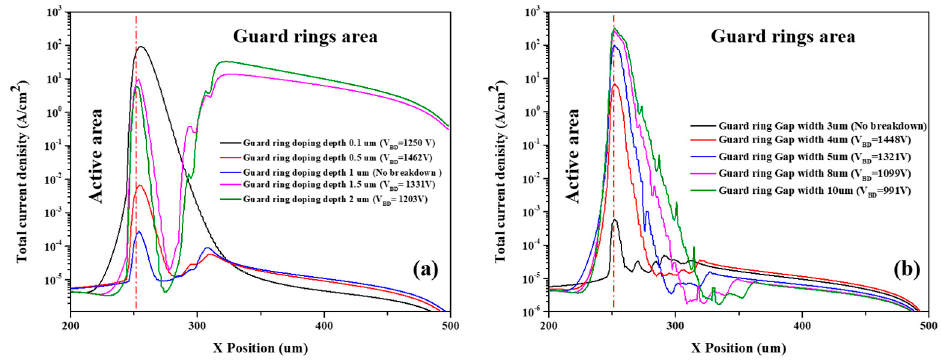
Figure 10. The total current density simulated results of the Hybrid-SSBD device: ( a ) guard ring doping depth, ( b ) gap width of the innermost guard ring to active area (guard ring gap width). The red line separates the two regions of the active area and guard ring area.